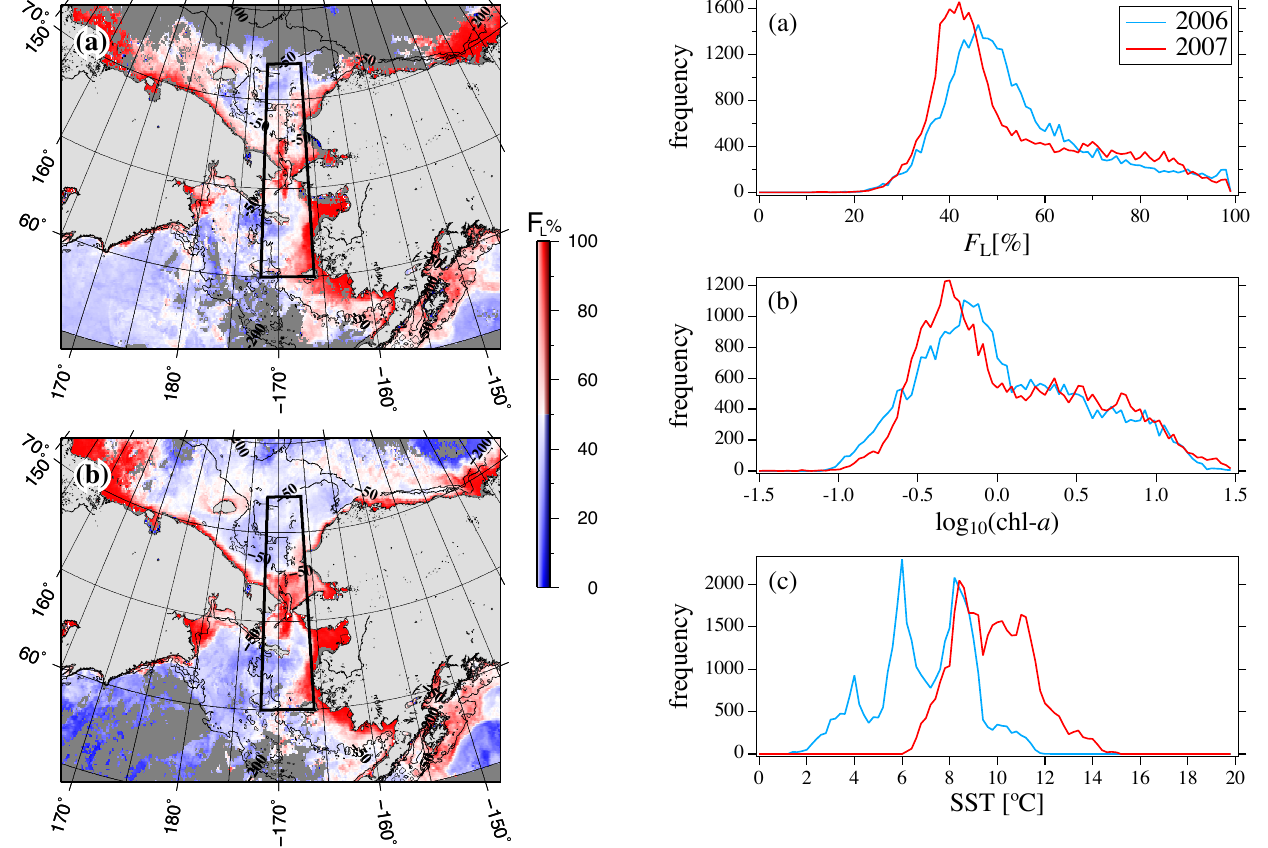
Fig. 5. Histograms of (a) F L , (b) log-transformed chl- a and (c) SST in the area defined in the shelf region (Fig. 4). Blue and red lines indicate the observations of August 2006 and of August 2007, re- spectively. Valid pixels in the area acount for 91% of the total pixels for both years. Statistical differences of F L , chl- a and SST are pro- vided in Table